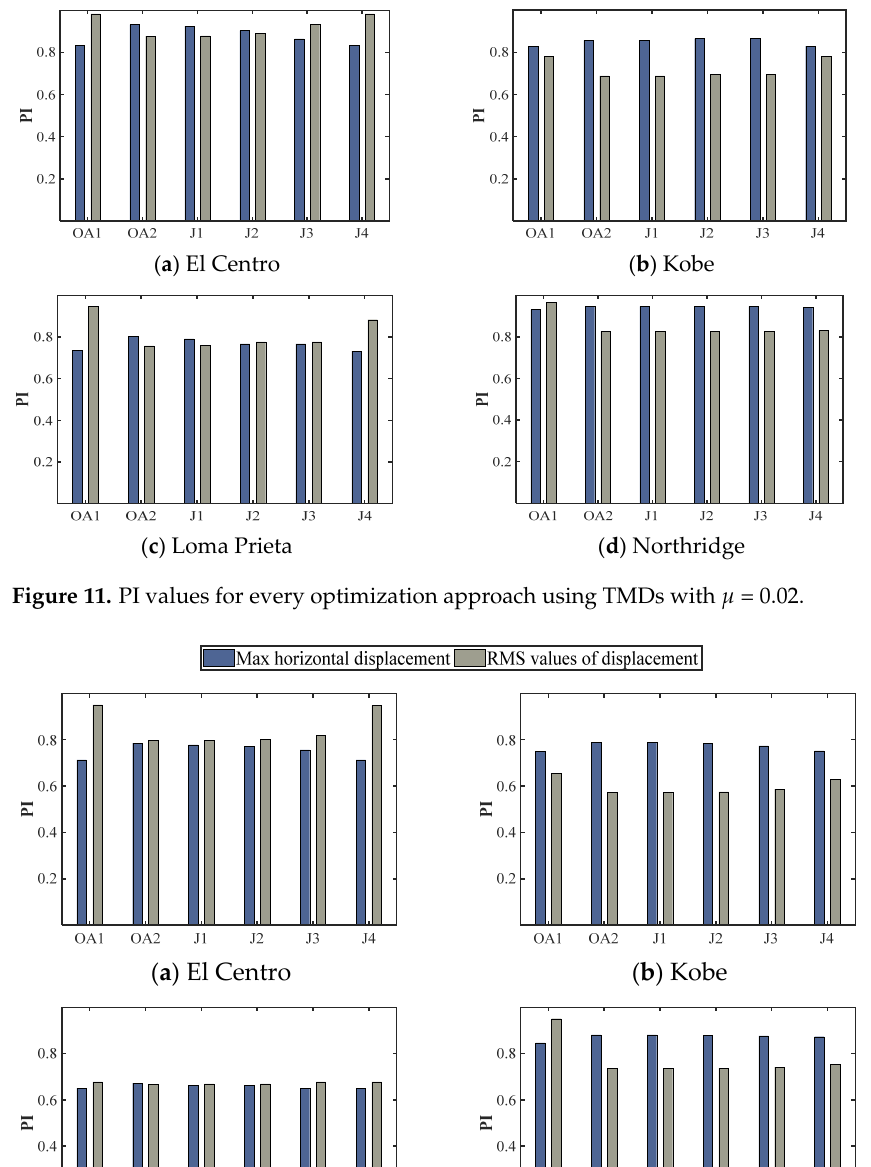
Figure 12. PI values for every optimization approach using TMDs with μ = 0.05.